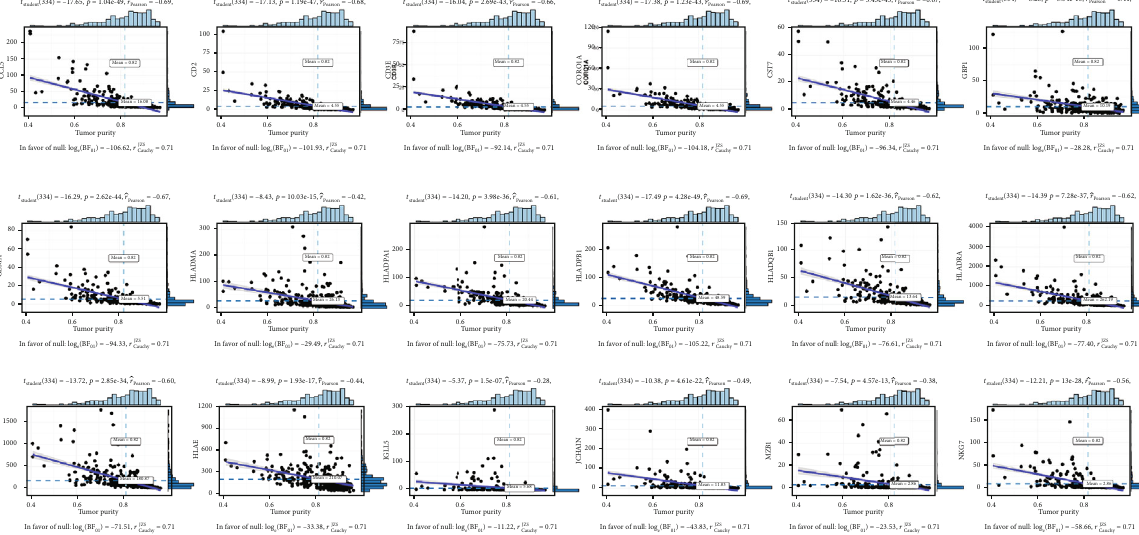
Figure 6: The Pearson correlation test among genes in magenta and grey60 modules with tumor